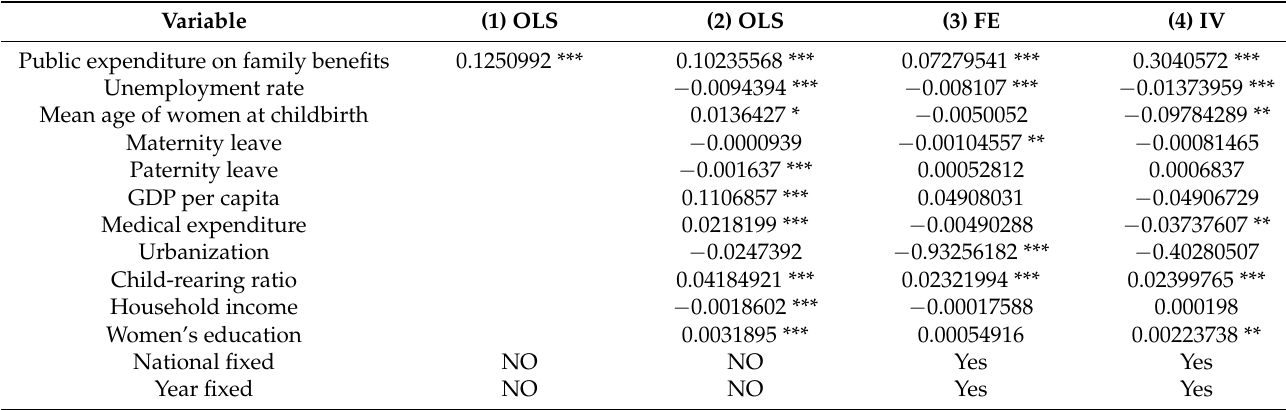
Table 4. Baseline regressions of family welfare policies to increase